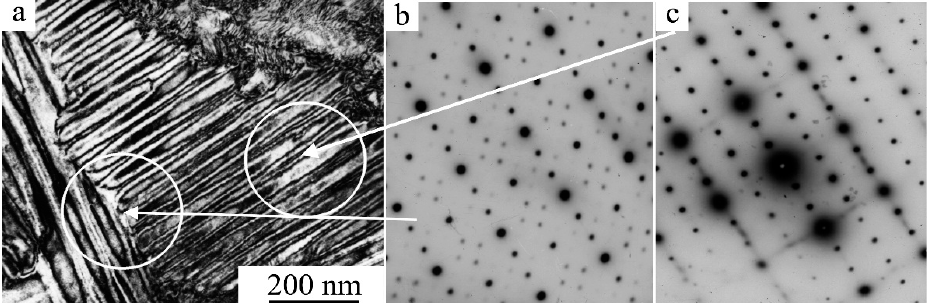
Figure 4. ( a ) Bright-field TEM image of the R martensite microstructure and ( b , c ) the corresponding SAED patterns with image size of selected diaphragm (SD) being 0.3 µm (z.a. [010] R and [001] R ) of Ti 49.4 Ni 50.6 quenched alloy [72].